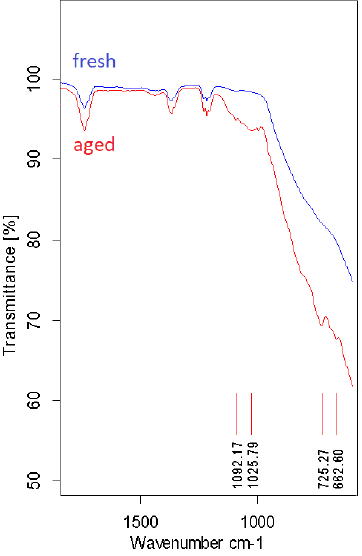
Figure 19. FTIR-ATR spectra of the vehicle-aged and fresh natural gas catalysts.